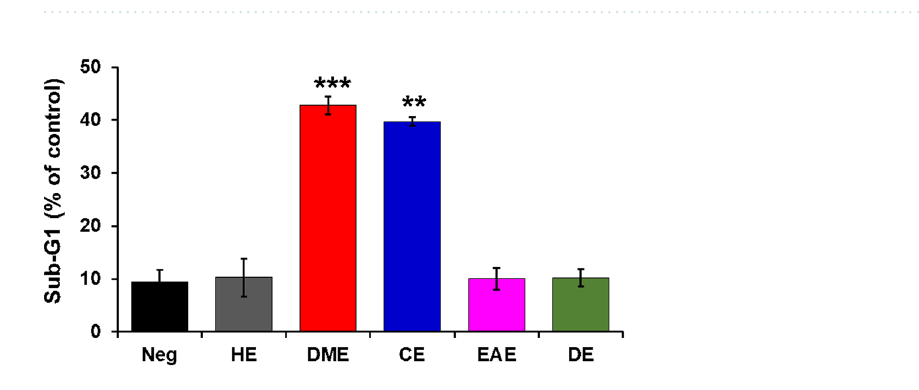
Figure 3. Effects of M. glyptostroboides extracts on the nuclei of HeLa cells. HeLa cells were incubated with M. glyptostroboides extracts of 50 µg/ml for 24 h. Apoptotic cells indicated as bright colored condensed and fragmented nuclei stained with Hoechst 33342 (marked by arrow).